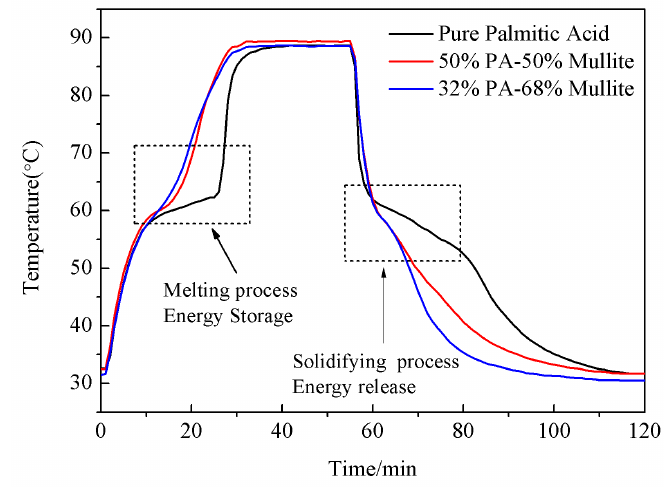
Figure 8. The cooling curves of PA and PA/mullite composites.